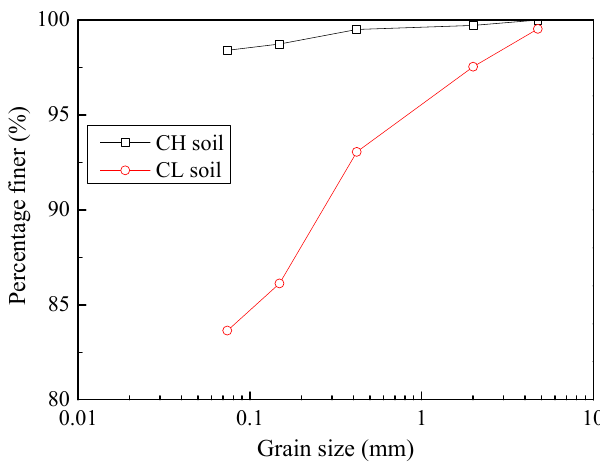
Figure 1. Grain size distribution of Nandipur (CH) and DHA (CL) soil samples.